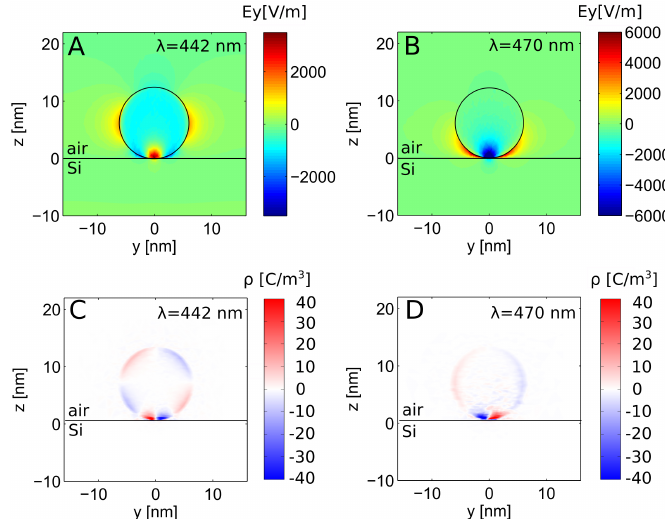
Figure 6. Nonlocal modes after Autler–Townes splitting due to strong coupling for a = 6 nm. Cut through the particle center at x = 0. ( A , B ) Field distribution and ( C , D ) induced charge distribution for the ( A , C ) mode shifted to higher energy and ( B , D ) Mode shifted to lower